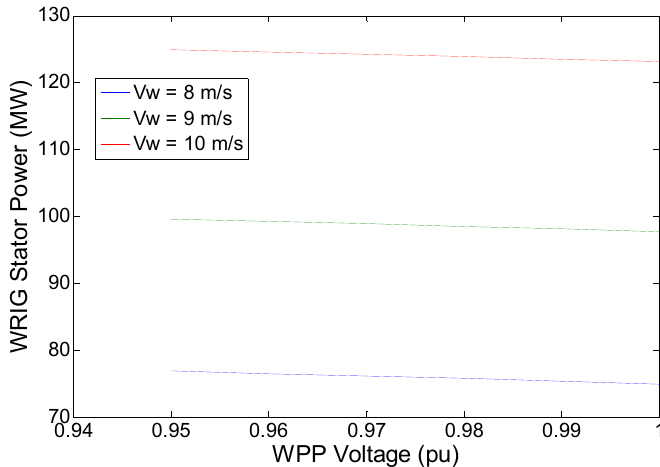
Figure 11. Variation of WPP reactive power loss.